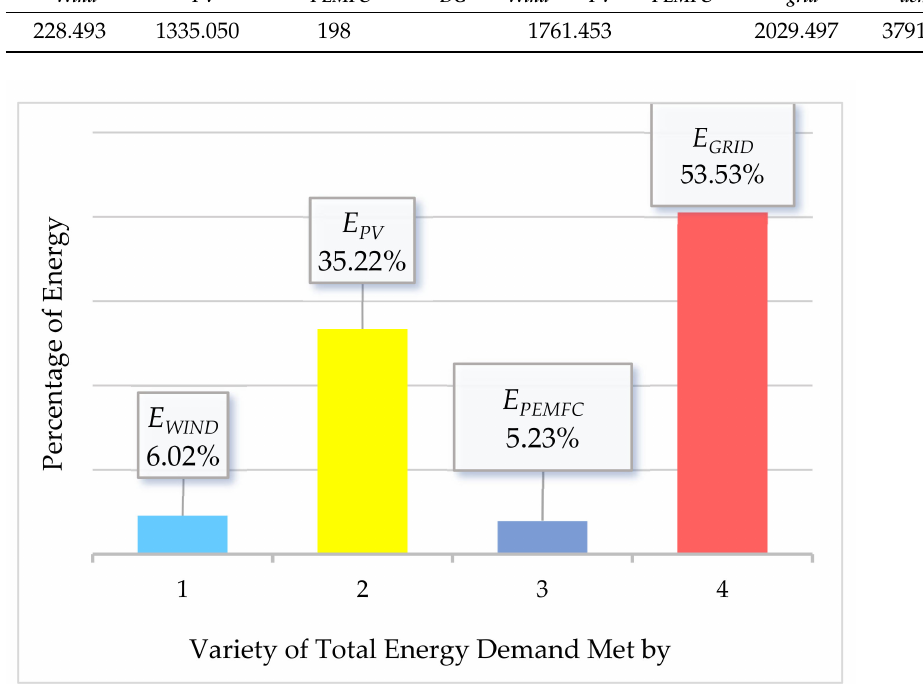
Figure 16. The pie chart of power generation and grid support rates of the microgrid for a defined